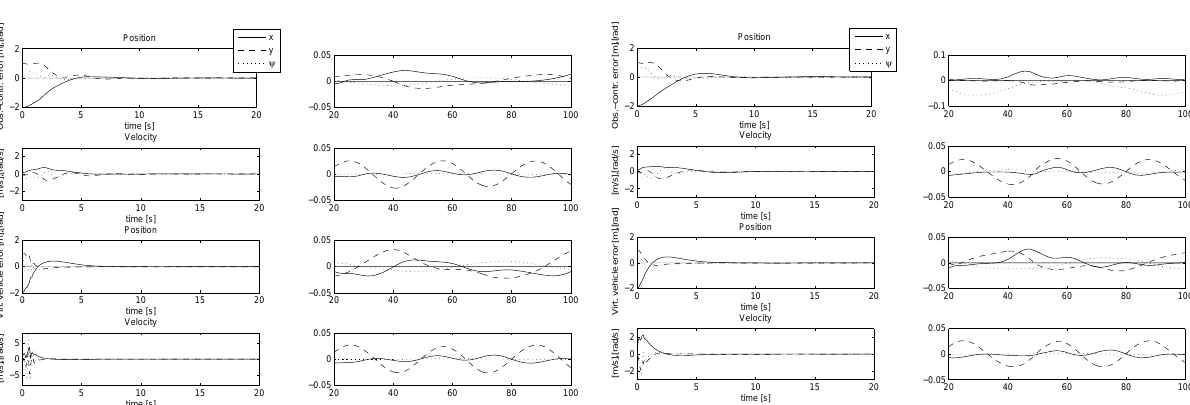
Figure 5: Performance of the dynamic observer scheme (top two rows) and kinematic observer scheme (bot- tom two rows) under velocity